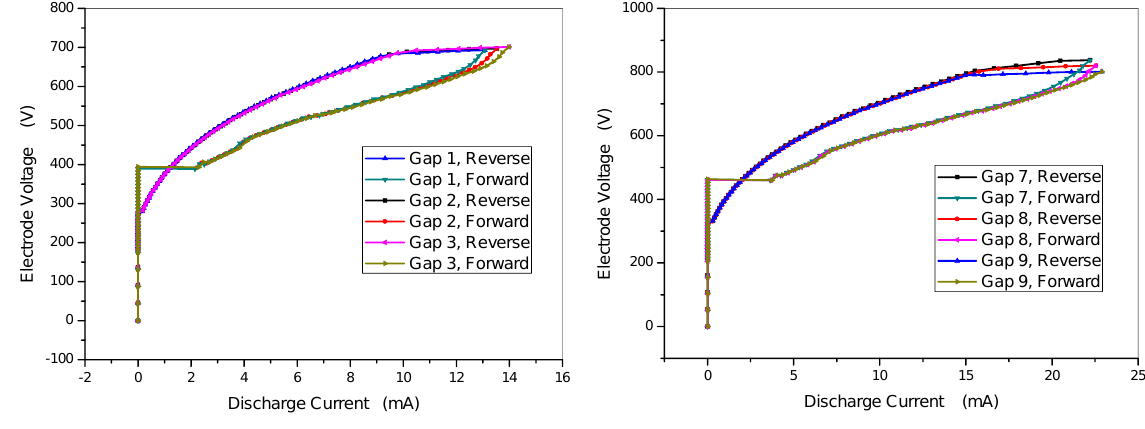
Figure 9: V − I characteristic and hysteresis for similar gaps ( d/r =